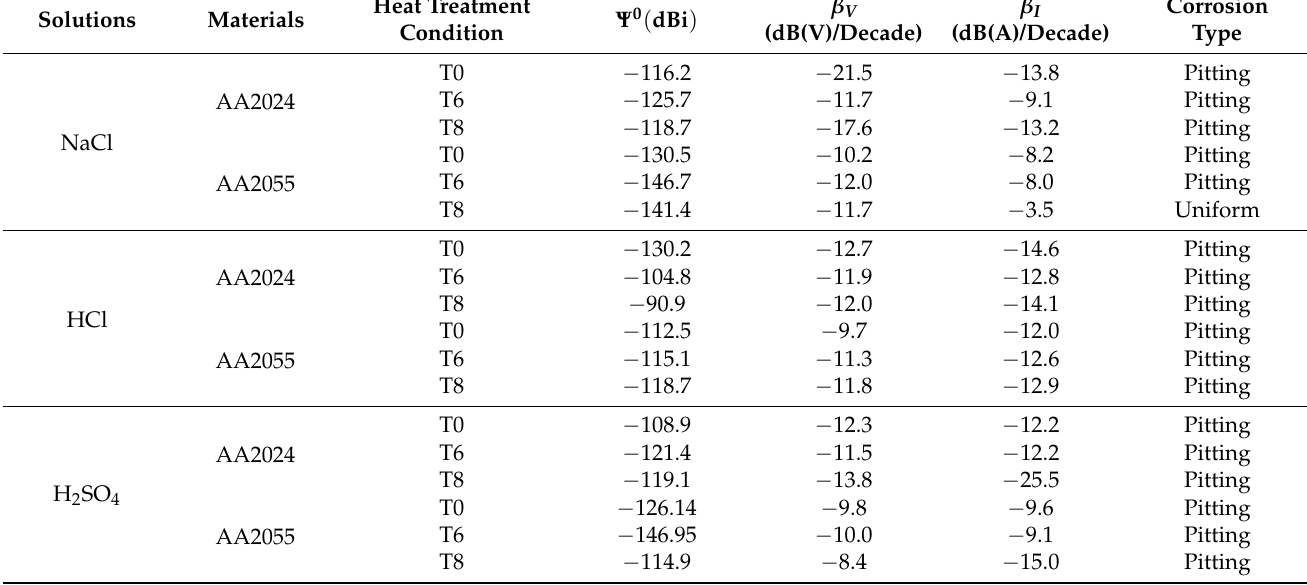
Table 7. Parameters obtained by PSD for heat treatment condition and exposed to 3.5 wt. % NaCl, 1 wt. % HCl, and 1 wt. % H 2 SO 4